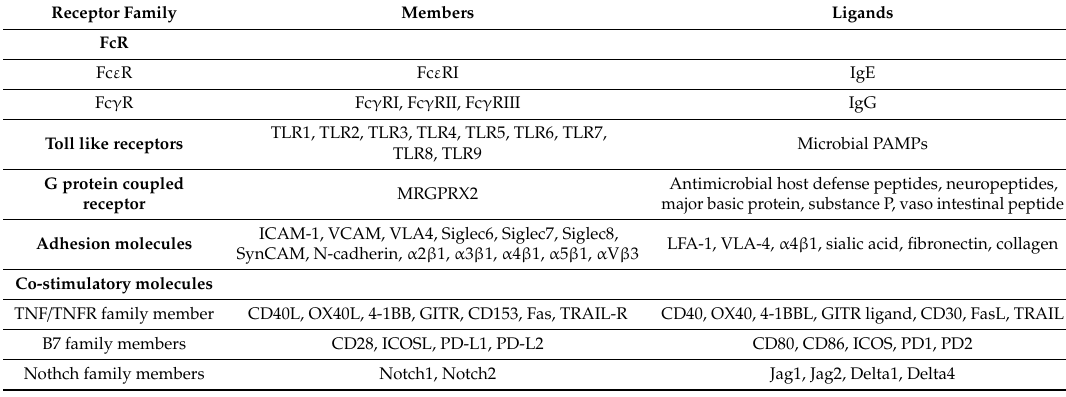
Table 1. Mast Cell (MC)